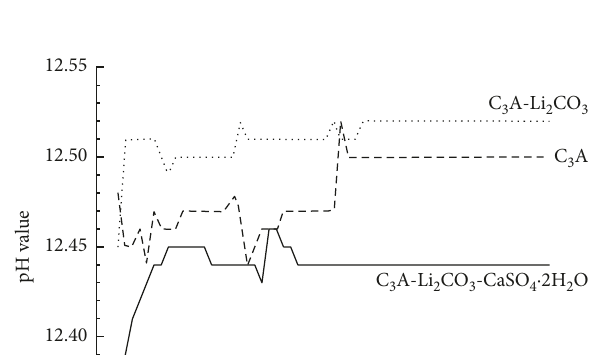
Figure 3: The flowchart of pastes preparation.